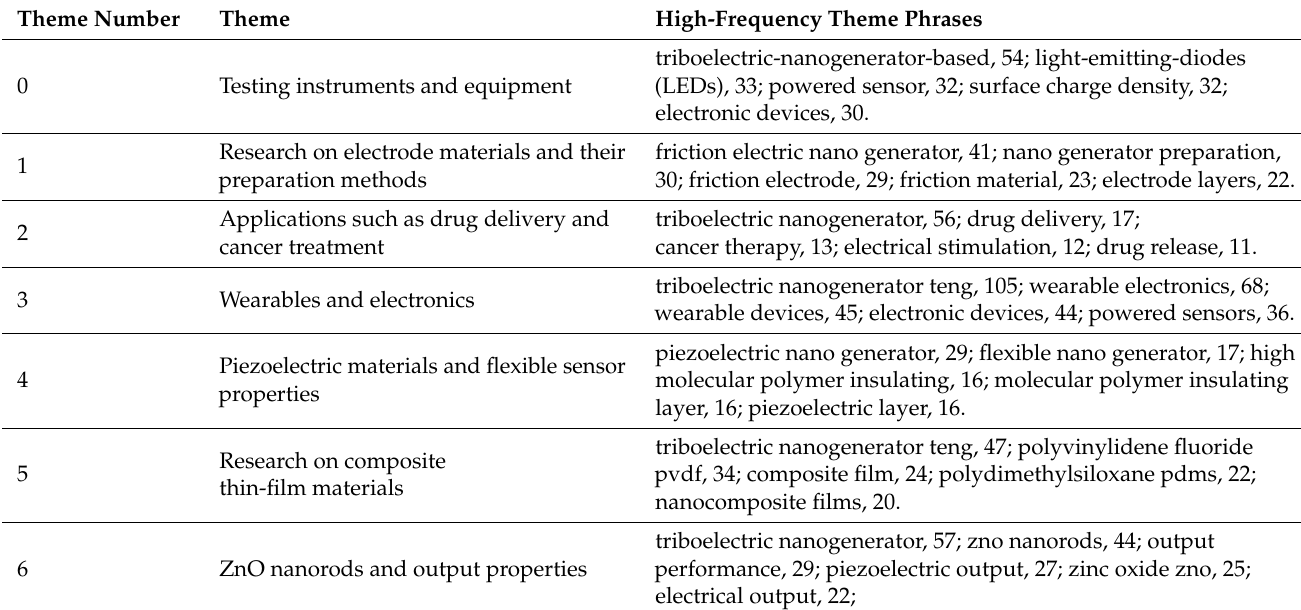
Table 2. Theme modeling results of multi-source fusion texts.